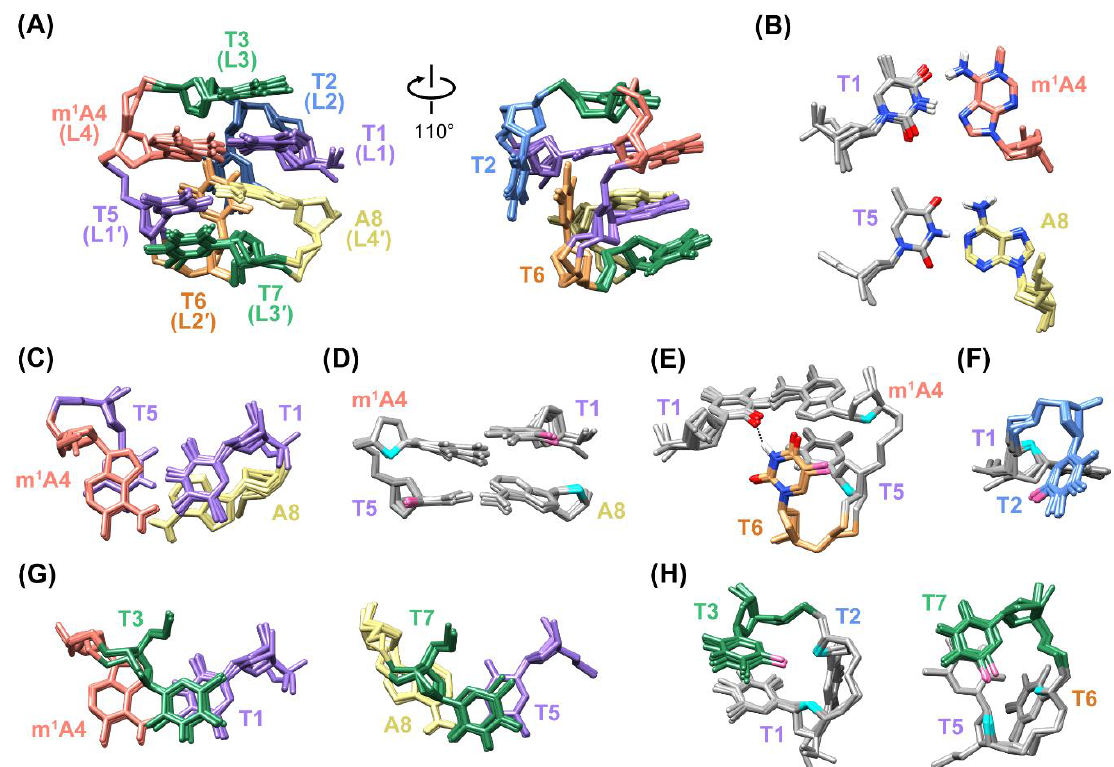
Figure 3. ( A ) The five superimposed solution structures of the m 1 A MDB (PDB ID: 7E4E). ( B ) T1·m 1 A4 Hoogsteen and T5-A8 Watson–Crick base pairs. ( C ) Base–base stackings between T1·m 1 A4 and T5-A8 base pairs. ( D ) Hydrophobic contacts between the methyl group (pink) of T1 and 2′-methylene group (cyan) of A8, and between the methyl group of T5 and 2′-methylene group of m 1 A4. ( E ) The T6 H3-T1 O2 hydrogen bond, and hydrophobic contacts between the methyl group of T6 and 2′-methylene groups of m 1 A4 and T5. ( F ) Hydrophobic contact between the methyl group of T2 and 2′-methylene group of T1. ( G ) Base–base stackings between T3 and T1·m 1 A4, and between T7 and T5-A8. ( H ) Hydrophobic contacts between methyl groups of T3/T7 and 2′-methylene groups of their two preceding residues.